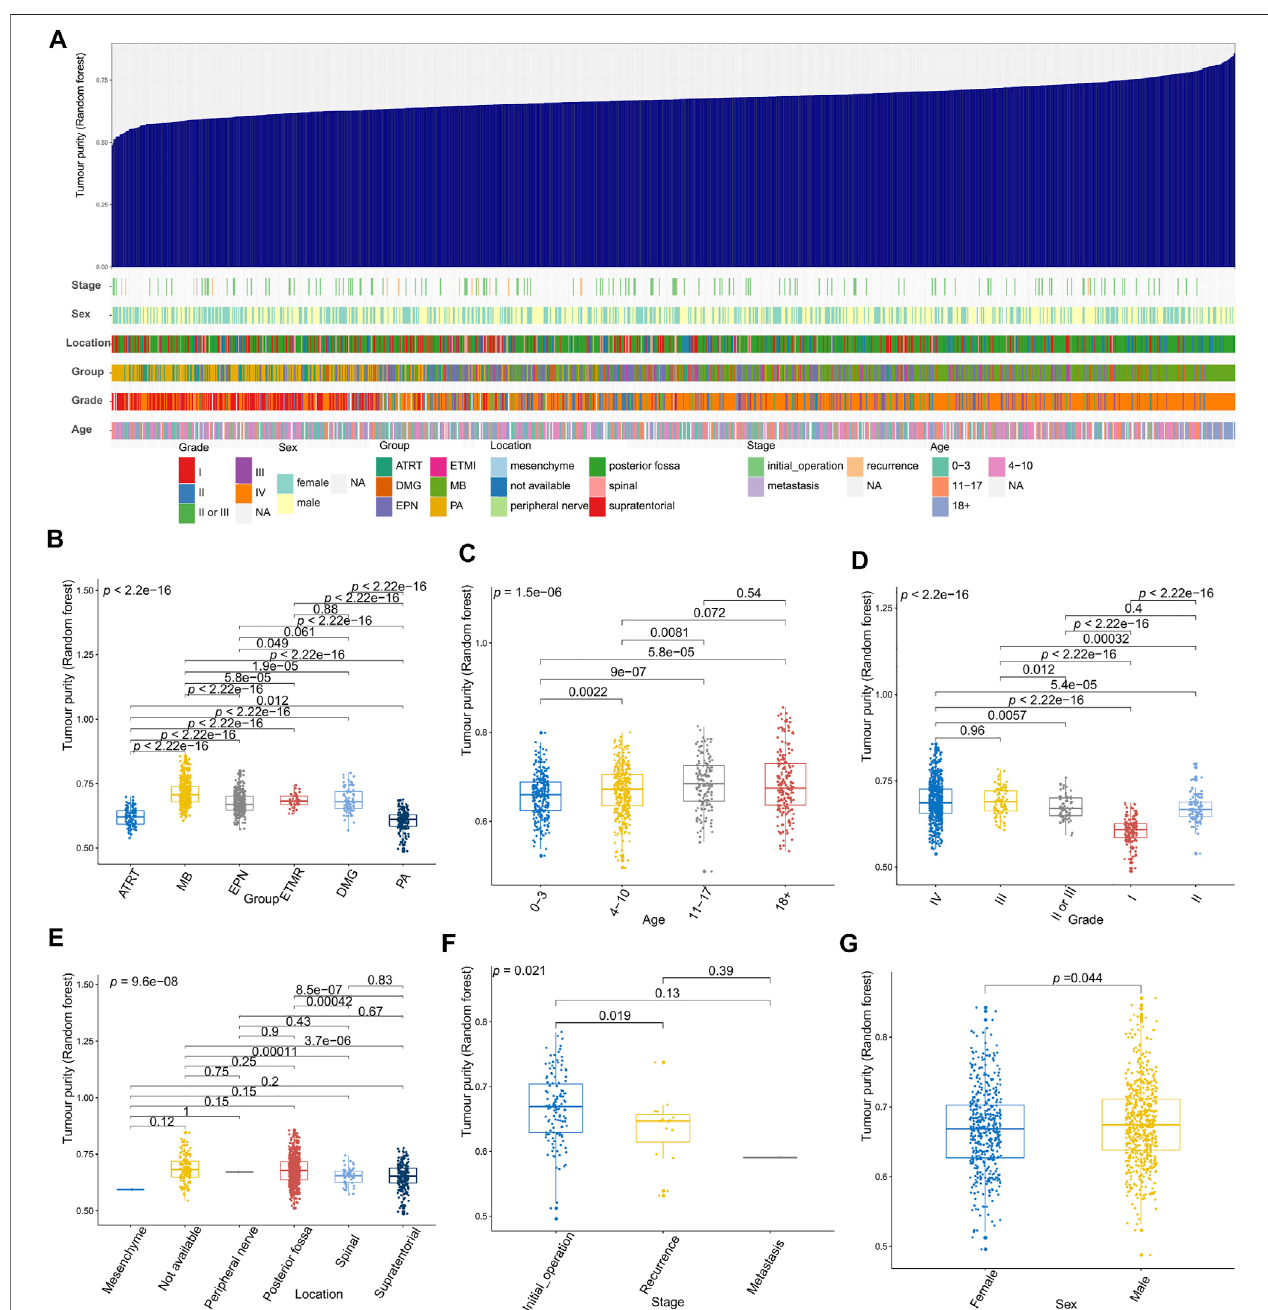
FIGURE 2 | Relationship between tumor purity and the patients ’ clinical features in the GSE90496 dataset. (A) An overview of the correlation between the clinical featuresandtumorpurityintheGSE90496dataset; (B) boxplotofthetumorpuritybytumorhistology; (C) boxplotofthetumorpuritybyageatdiagnosis; (D) boxplotof the tumor purity by the tumor grade; (E) Box plot of the tumor purity by the tumor location; (F) box plot of the tumor purity by the tumor grade; (G) box plot of the tumor purity by the patient gender.